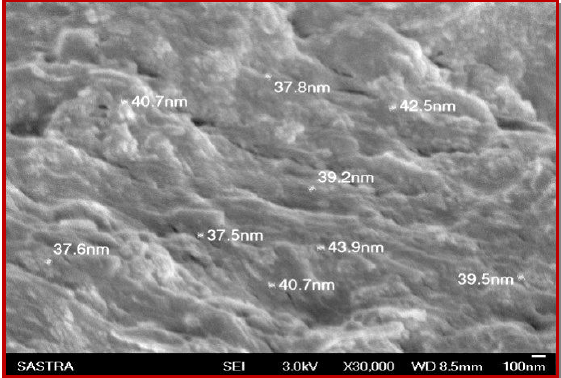
Figure 3: SEM image of AgNPs synthesized from Sargassum polyphyllum